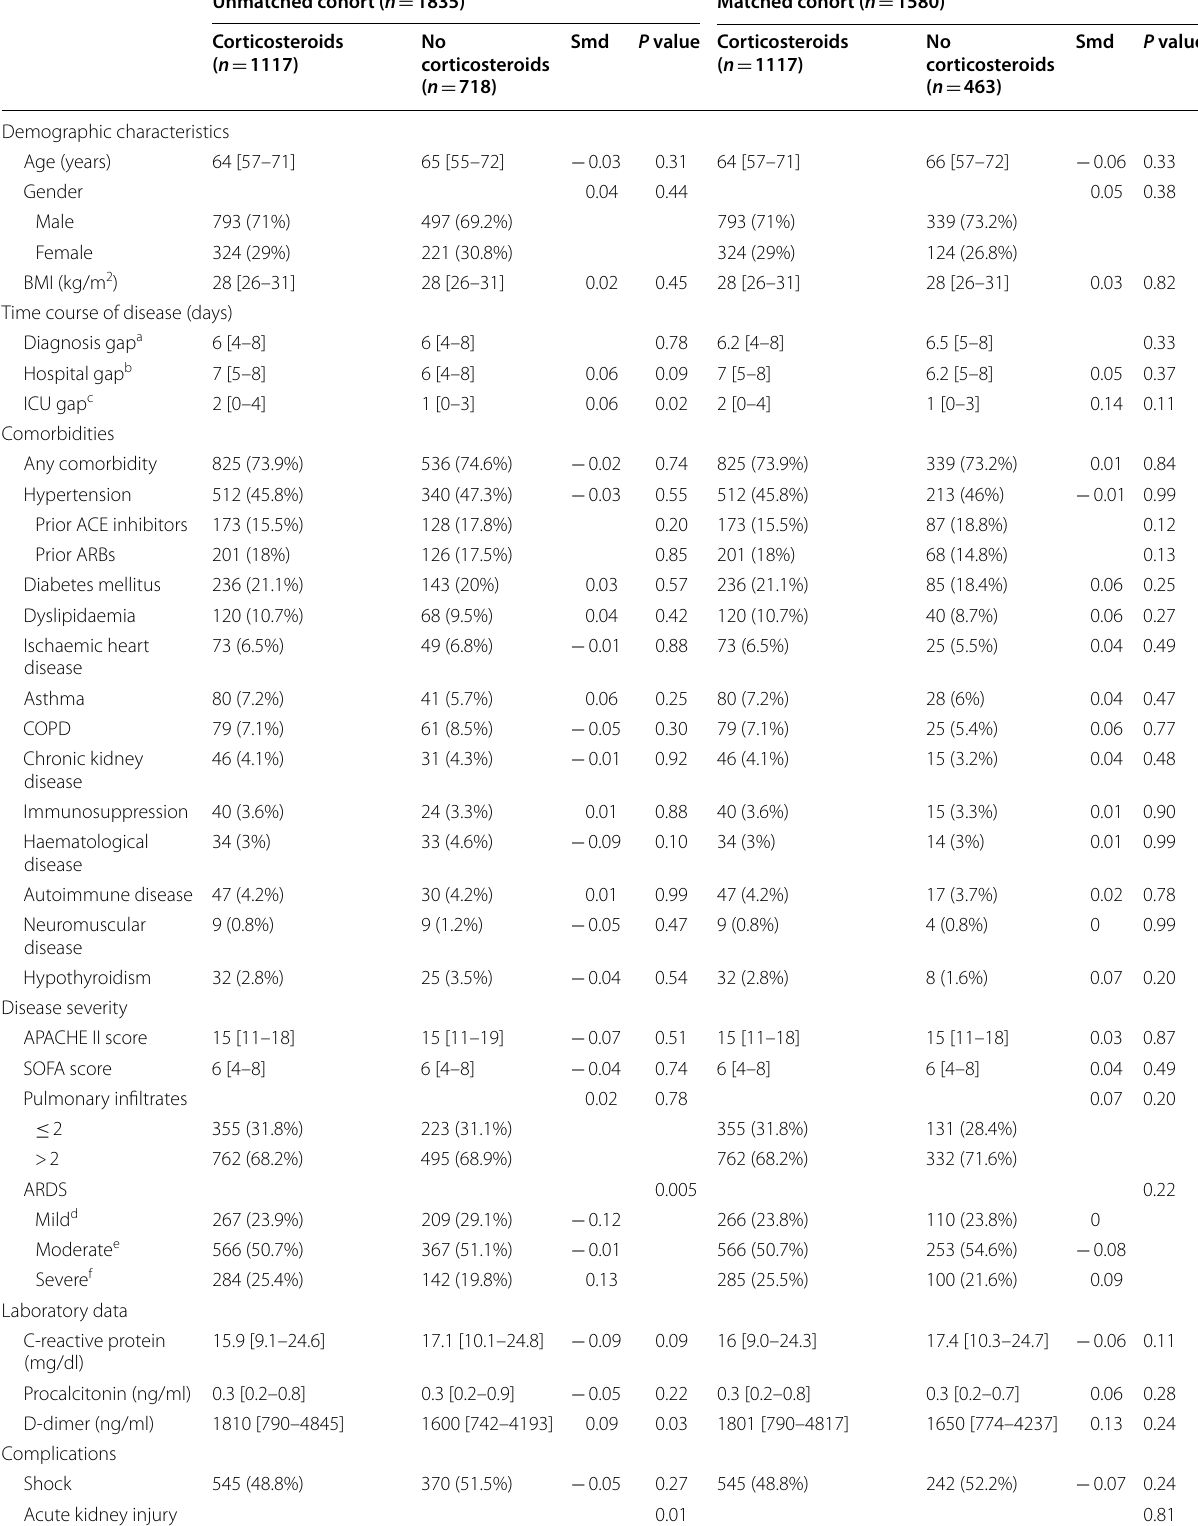
Table 1 Baseline characteristics of groups according to corticosteroid treatment before and after propensity score